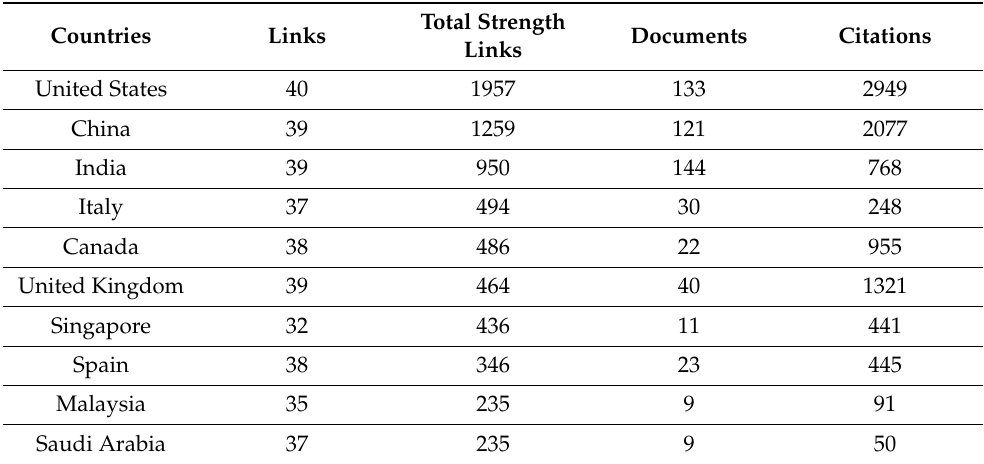
Table 23. Countries with bibliographic coupling, links, total strength links, documents, and citations. Total Strength Countries Links